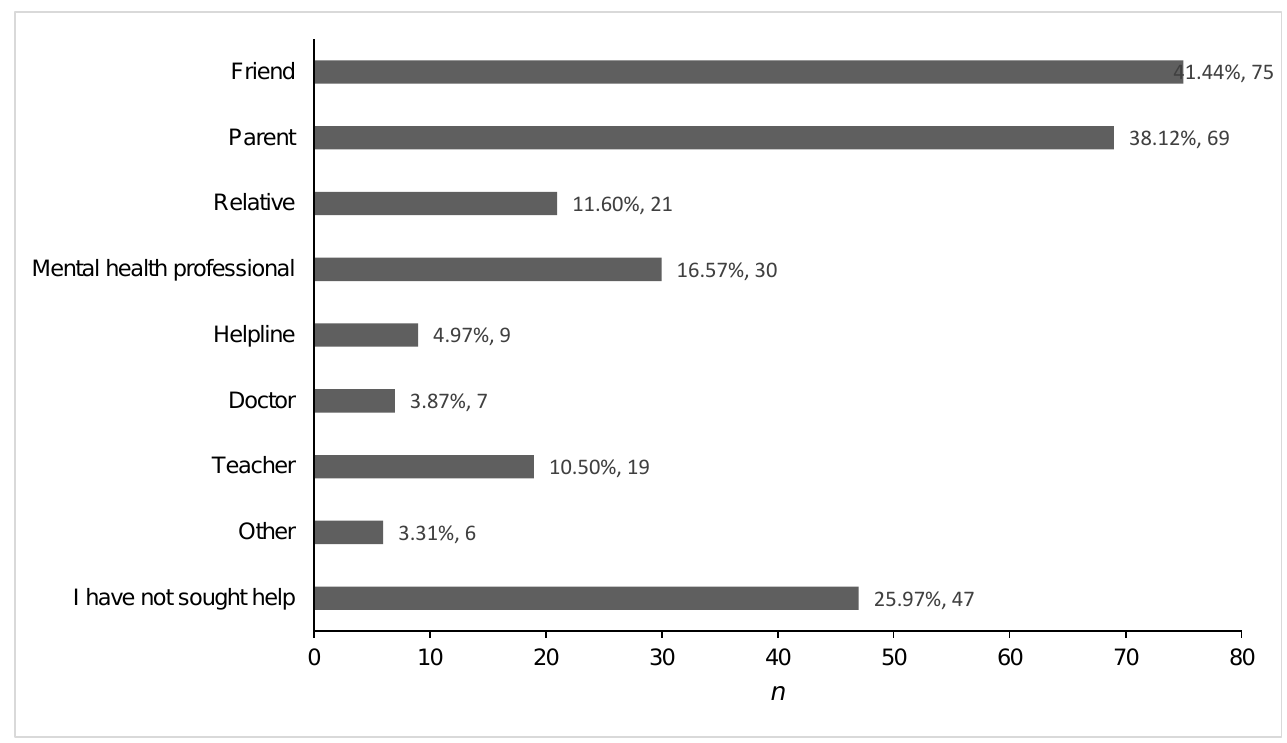
Figure 1. Sources of help sought from in the past two weeks.